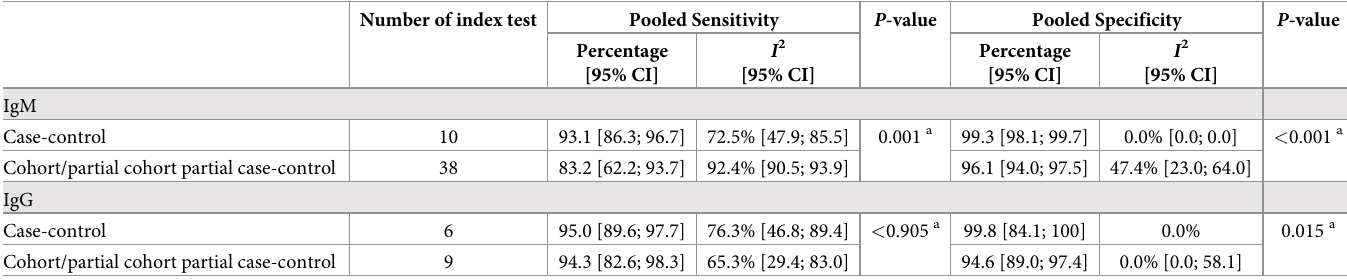
Table 10. Subgroup analysis for study